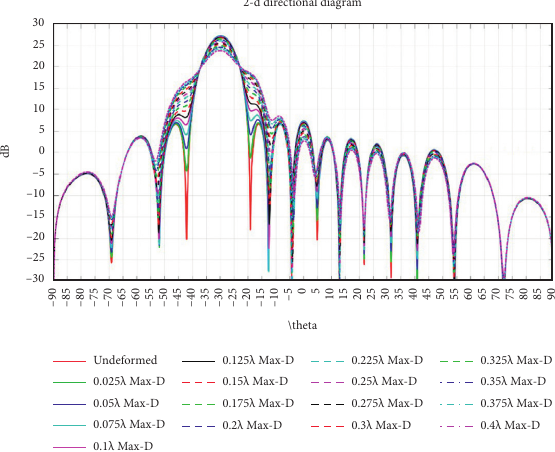
Figure 23: Saddle-shaped deformation elevation scanning − 30 ° direction